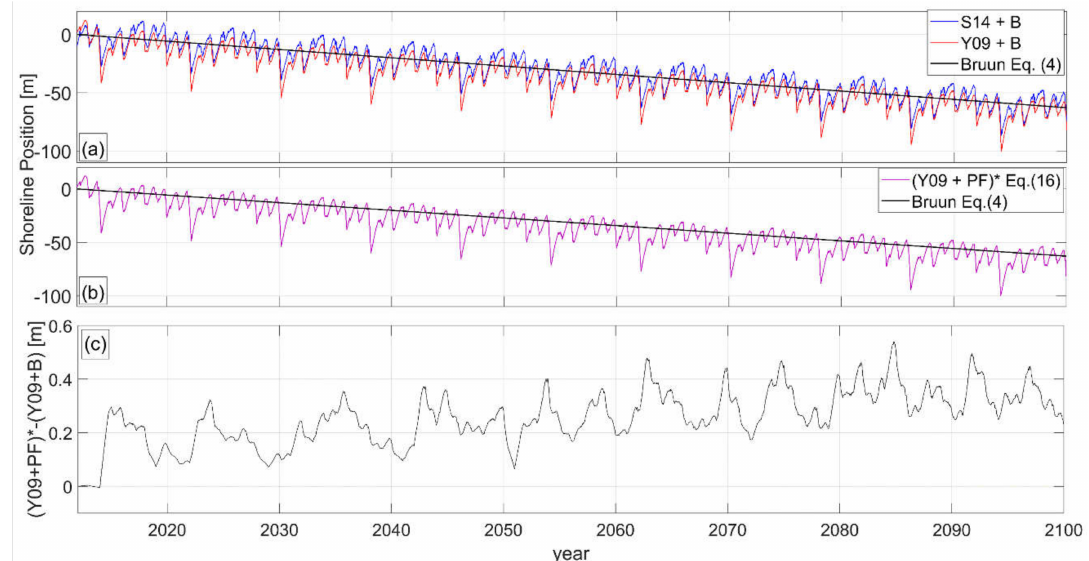
Figure 8. ( a ) Model Results for the Y09 and S14 approaches integrated with the Bruun model with no feedback (red and blue curve, respectively), using Equations (9) and (12), respectively, and the sole Bruun model (black curve); ( b ) Model results for the Y09 approach integrated with the PF with feedback (red curve), using Equation (15), and the sole Bruun model (black curve); ( c ) difference between the (Y09 + PF)* and (Y09 + B) model results. The negative and positive dS correspond to erosion and accretion, respectively. Table 2. Eight-year averaged shoreline position at 2100, and minimum, maximum and standard deviation of the shoreline position over the last 8 simulated years, for (Y09 + PF)*, (Y09 + B) and the Bruun Rule. Shoreline Position 8-Year Mean from at 2100 Model [m] (Y09 + B) Bruun −